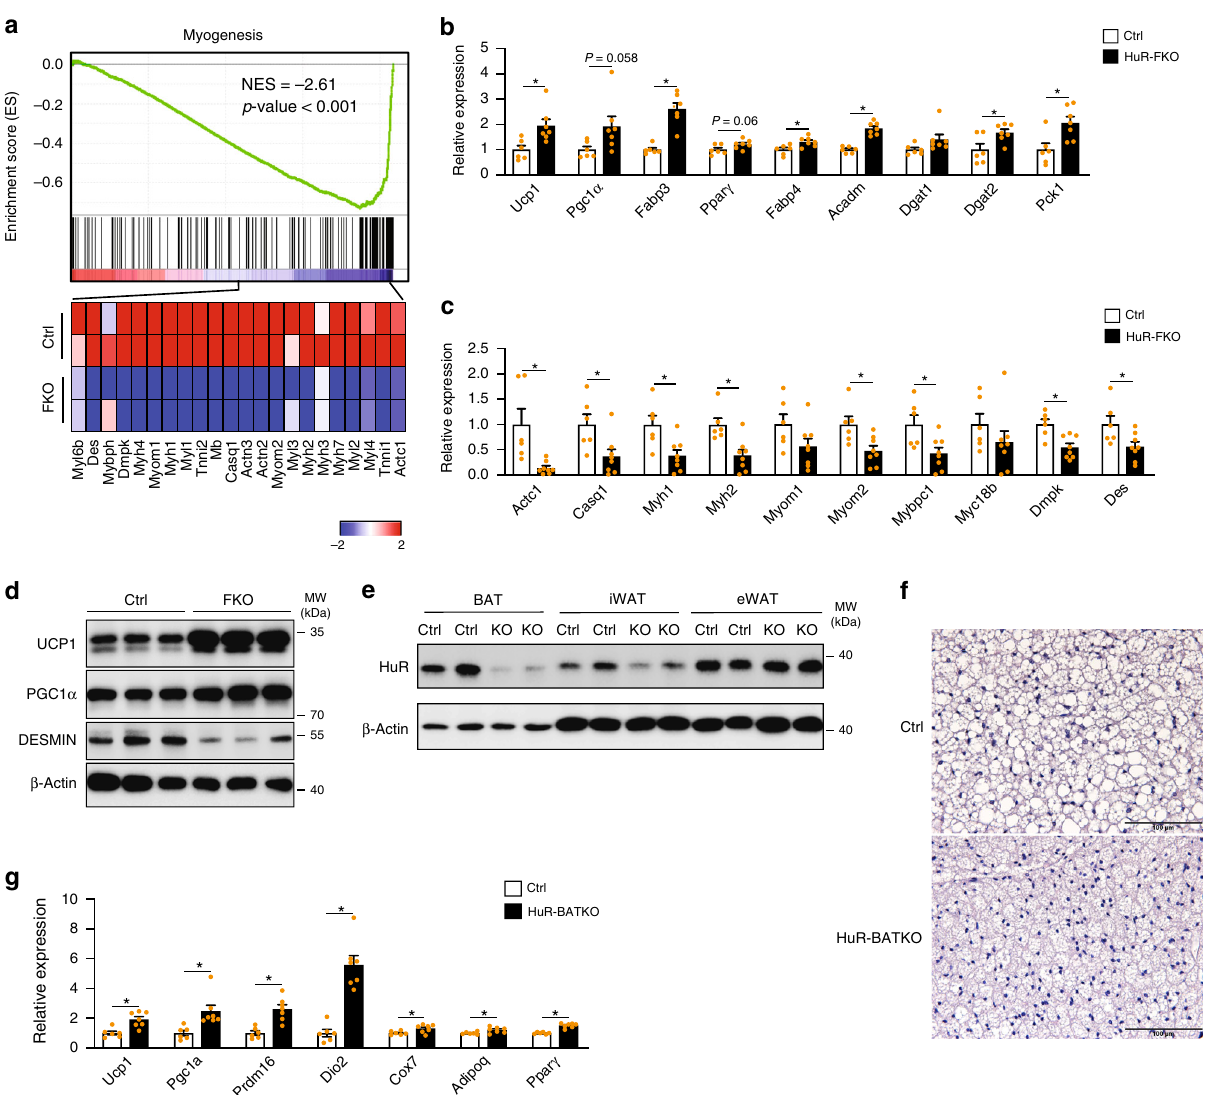
Fig. 5 Deletion of HuR in BAT promotes brown adipogenesis. a GSEA on HuR-FKO and Ctrl BAT indicated that myogenesis pathway was signi fi cantly downregulated in HuR knockout BAT. b Real-time PCR to con fi rm the expression of BAT-selective markers, adipogenesis, lipogenesis (Ctrl, n = 6; HuR-FKO, n = 7), and c muscle markers (Ctrl, n = 6; HuR-FKO, n = 8). d Western blot to exam the protein level of Ucp1, Pgc1a, and Desmin in BAT from HuR-FKO and Ctrl mice. e Western blot analysis of HuR expression in BAT, iWAT, and eWAT of HuR-BATKO and control mice. f Morphological characteristics of HuR-BATKO and control littermates by H&E staining. Scale bars represent 100 μ M. g Real-time PCR to con fi rm the expression of genes for BAT-selective markers and adipogenesis in BAT from HuR-BATKO and Ctrl mice (Ctrl, n = 6; HuR-BATKO, n = 7). Error bars are mean ± SEM. Statistical signi fi cance was determined by Student ’ s t -test; * p < 0.05. Source data are provided as a Source Data fi